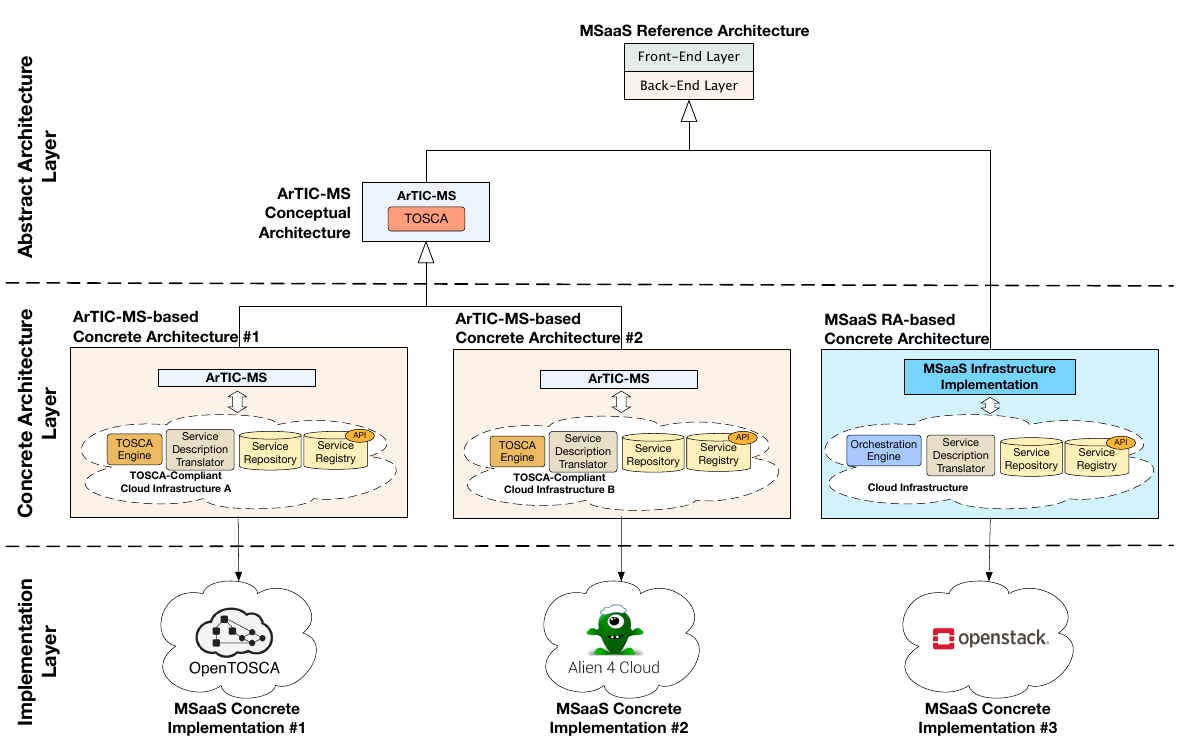
Figure 5. Relationships among different architectural